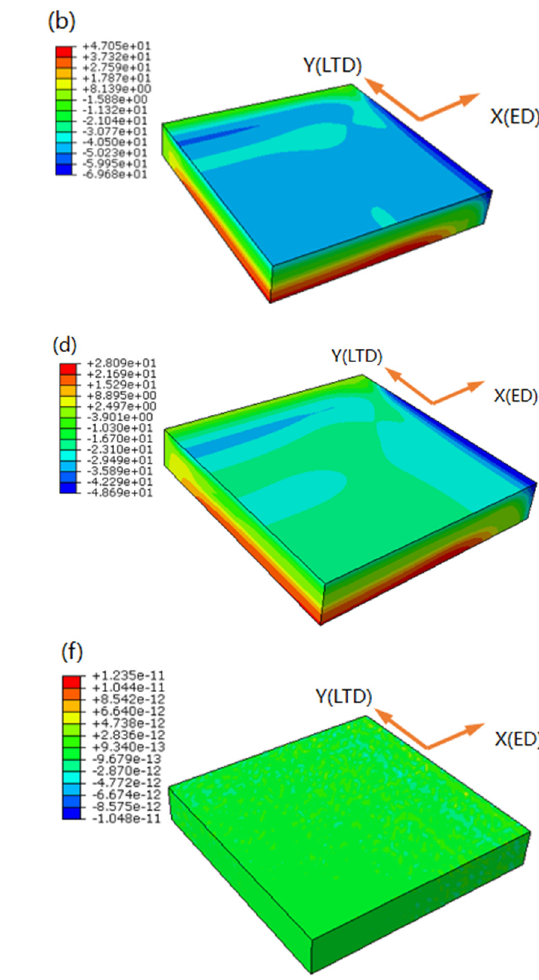
Figure 11. Simulation and experimental results of RS in XRD along path AB. The inner RS of the samples measured by the contour method were shown in Fig- ure 12a in WQ (20 °C) and Figure 12c in WQ (100 °C), Figure 12b,d were corresponding simulation results. The edge of the cross-sections could not be measured with the coor- dinate measurement machine; therefore, the data processing was not accurate due to outward interpolation; only RS within the range of measurement points in Section 2.2 was considered, so the tensile RS in the center part of the cross-sections was more accu- rate than compressive RS in the edge part of the cross-sections in Figure 12, and tensile RS was the main topic discussed below. From Figure 12b,d, it is revealed that RS distribution in the cross-sections was total- ly symmetry from the edge to the center, and it was a “runway” type distribution theo- retically, with compressive outside and tensile inside, the only difference was the maxi- mal tensile RS value in WQ (20 °C) and WQ (100 °C) were 47.05 MPa and 28.09 MPa, re- spectively. However, compared with Figure 11 the RS distribution was still the largest tensile stress in the middle area of the cross-sections, but it is not regular. The main rea- son was that the boundary conditions during quenching are not as symmetric as the fi- nite element simulation. For example, the generation of bubbles has certain randomness, and the generation and breakage of bubbles are inconsistent on the upper and lower sur- faces.